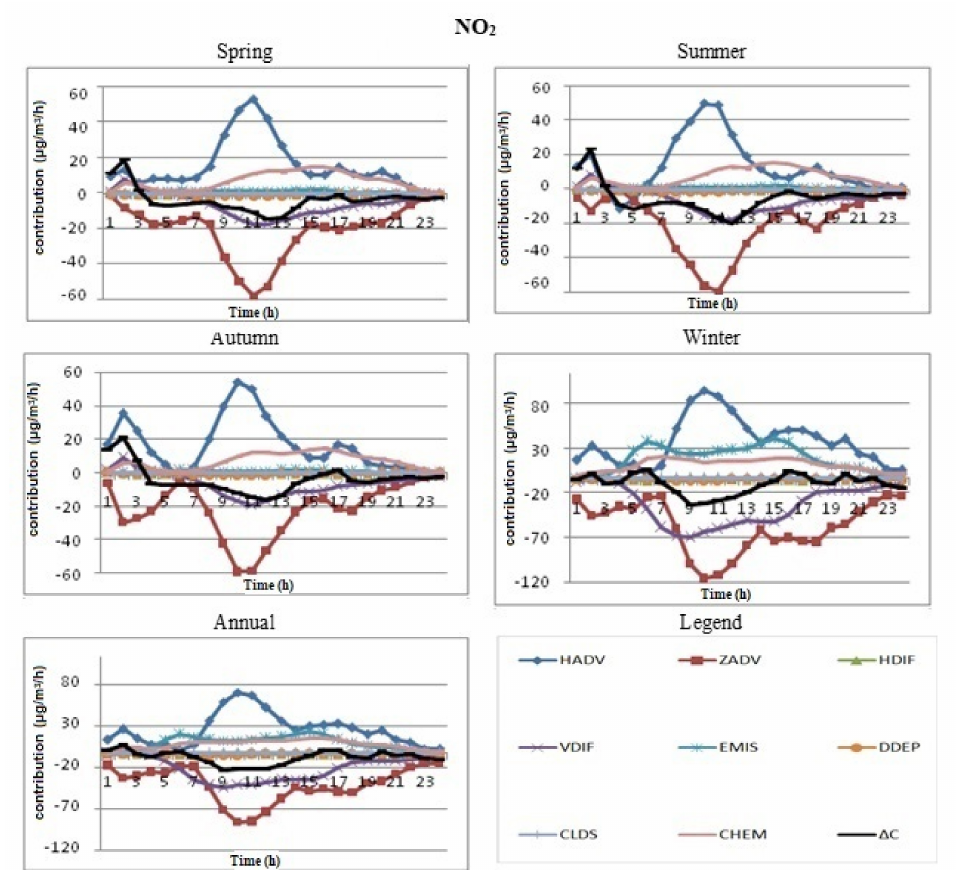
Figure 10. Annual, seasonal and diurnal course of the contribution of the different dynamic and chemical processes of the formation of NO 2 concentrations ( µ g/m 3 /h) averaged for Orlov most for the period